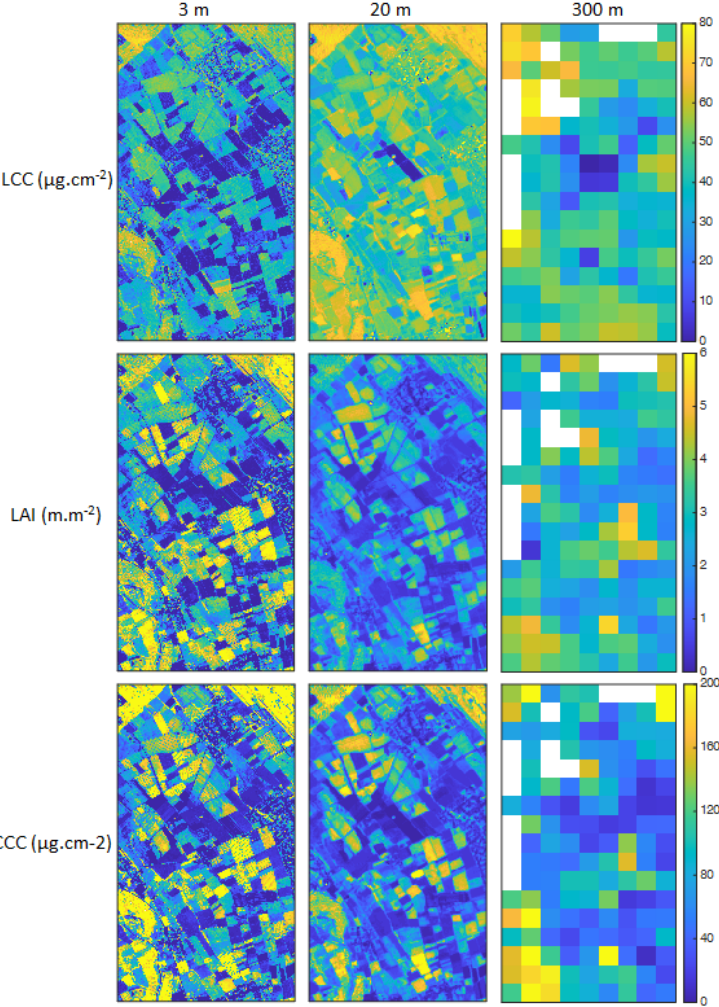
Figure 3. Variable maps (LCC, LAI, CCC) at the three spatial resolutions (see Figure 1 for location). First column: Retrieval maps obtained by applying our adapted OLCI models to the Hyplant* subset; second column: S2 SNAP vegetation products; third column: Retrieval maps obtained by applying our models to the S3-OLCI subset. White pixels represent either cloud pixels that were removed within the official S3 processing chain or pixels that were encountered as cloud-contaminated and removed within this study.